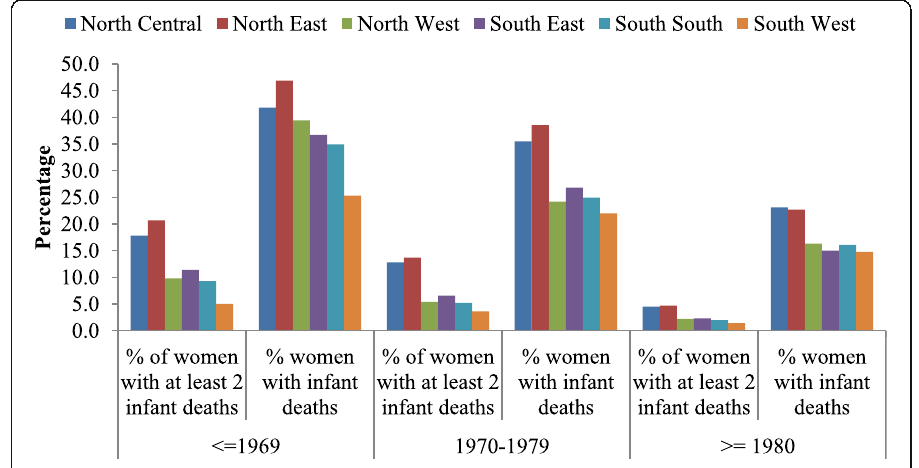
Fig. 1 Infant death clustering across the six geo-political regions of Nigeria, 1980 –